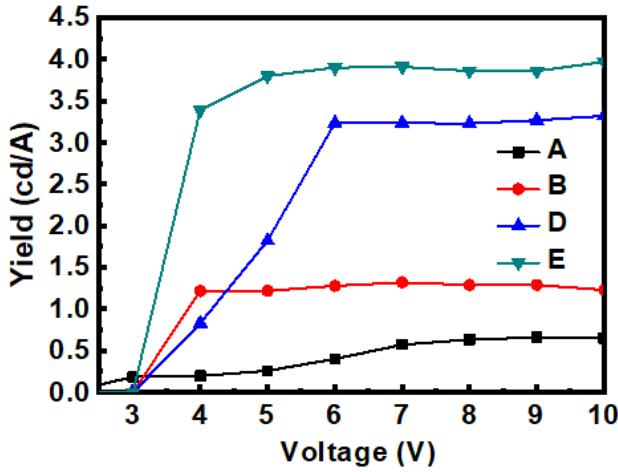
Figure 8. Current efficiency–voltage characteristic of OLEDs at each stage.